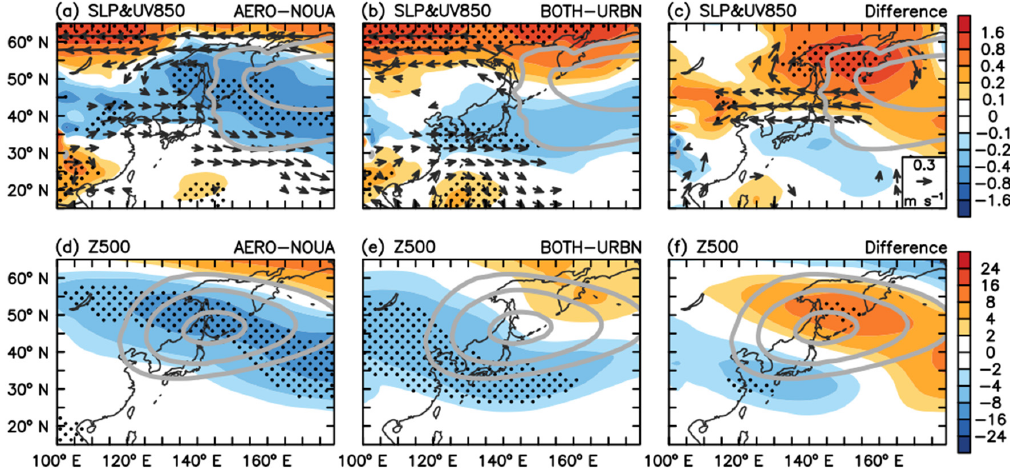
Figure 5. ( a – c ) NDJ-mean AA-induced changes in sea level pressure (SLP; color shading, in hPa) and 850 hPa horizontal winds (vectors, in m/s) over East Asia from ( a ) AERO − NOUA; ( b ) BOTH − URBN; and ( c ) their difference (i.e., ( b ) minus ( a )). ( d – f ) Same as ( a – c ), but for changes in Z500 (color shading, in gpm). Thick gray contours denote the climatology of ( a – c ) zonal deviation of SLP with values of − 10 and − 5 hPa (donating the Aleutian low) and ( d – f ) zonal deviation of Z500 with values of − 200, − 150, and − 100 gpm (donating the East Asian trough) in BOTH.